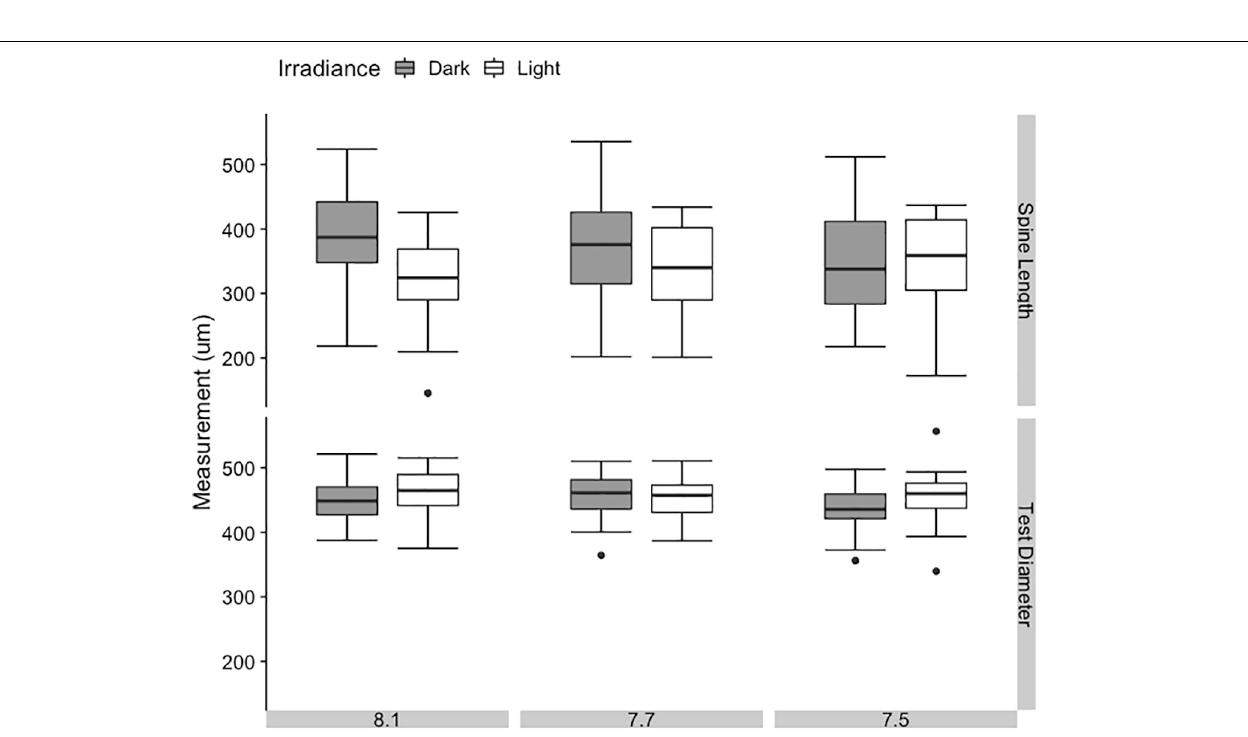
FIGURE 4 | Average spine length and test diameter in juvenile sea urchins Pseudechinus huttoni at 4 days post-settlement under three bulk seawater pH and two irradiance treatments. Each treatment (3 L aquaria) was replicated three times. Error bars are ± 1 SE of the mean.